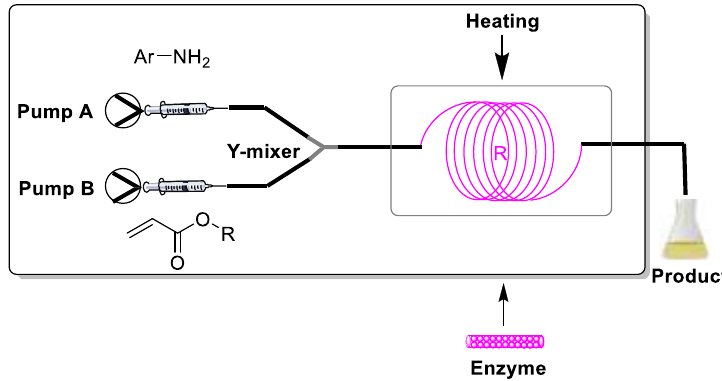
Figure 7. Experimental setup for the synthesis of β-amino acid esters.